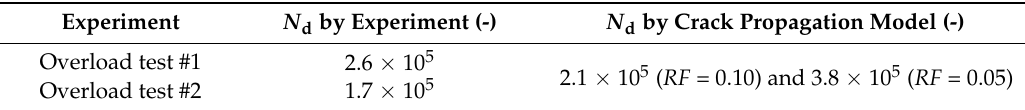
Table 4. Delay cycles N d by experiment and model for overload tests with R OL = 2.0.